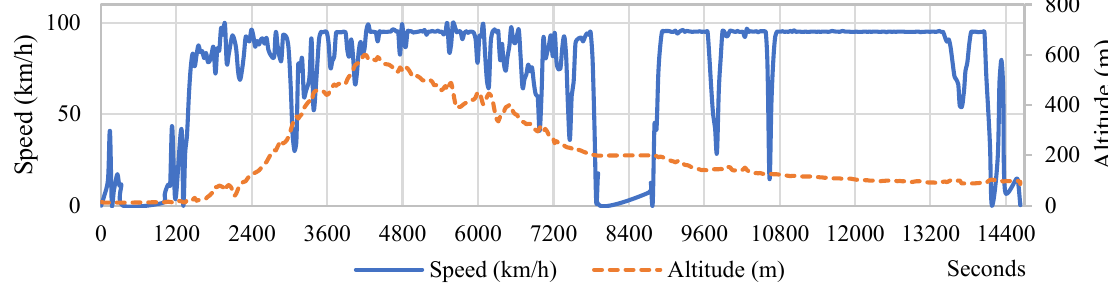
Figure 5. Drive cycle 4: GCM of 61,000 kg.